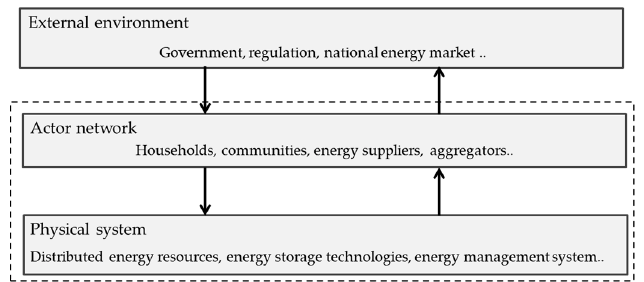
Figure 1. Community Energy Storage (CES) business models as a complex socio-technical system (own presentation based on [12]).